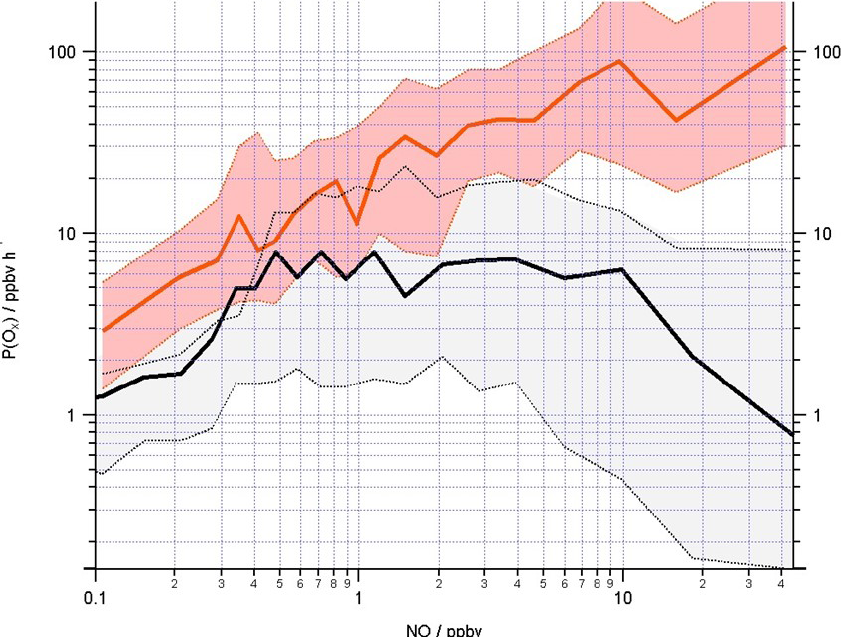
Figure 11. Mean O x production (ppbvh − 1 ) calculated from observed (red line) and modelled (black line) RO x concentrations using Eq. (11) binned over the NO mixing ratio range encountered during the campaign on a logarithmic scale. The shading represents the 25th and 75th percentile confidence limits. The number of data points in each of the NO bins is ≈